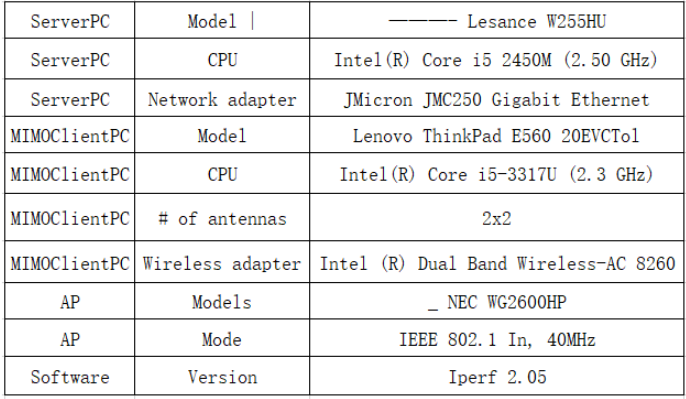
Figure 9. Excel table before merging the same cells.